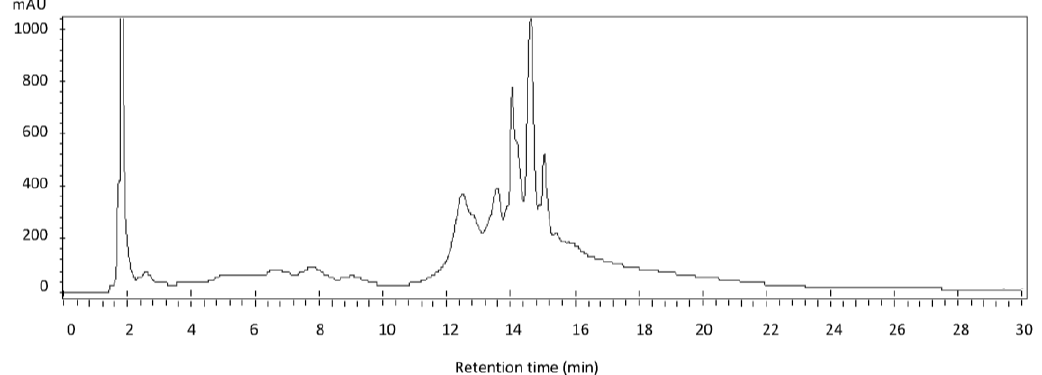
Figure 2. HPLC chromatogram of F-10 (40 µL of 10 mg/mL, C 18 -reversed phase, 4.6 × 150 mm, 5 μm, detected at 254 nm) showing the presence of multiple severely overlapped